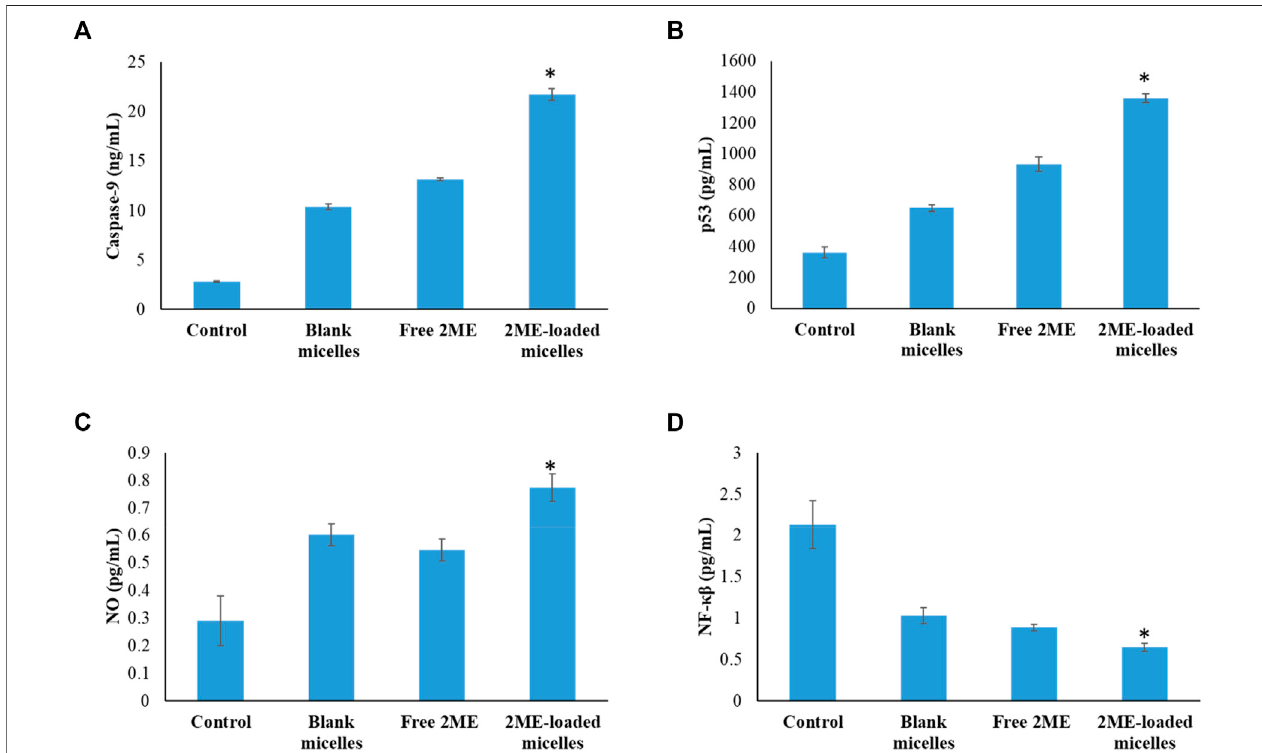
FIGURE9| Changeintheexpressionlevelsofcaspase-9 (A) ,p53 (B) ,NO (C) ,andNF- κβ (D) onthePC-3cellsfollowingincubationwithblankmicelles,free-2ME, and 2 ME-loaded micelles and vehicle control cells. * represents signi fi cant difference between 2 ME-loaded micelles vs other formulations group ( p < 0.05). Values are expressed as mean ± SD ( n (cid:2)